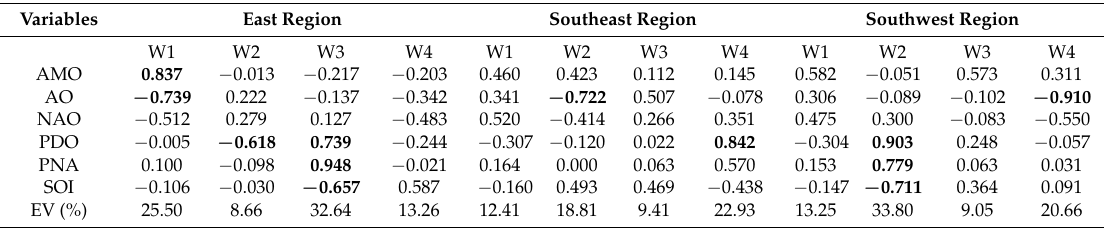
Table 4. Structure coefficients derived using winter seasonal (DJFM) climate indices in the three climatic regions. Climatic